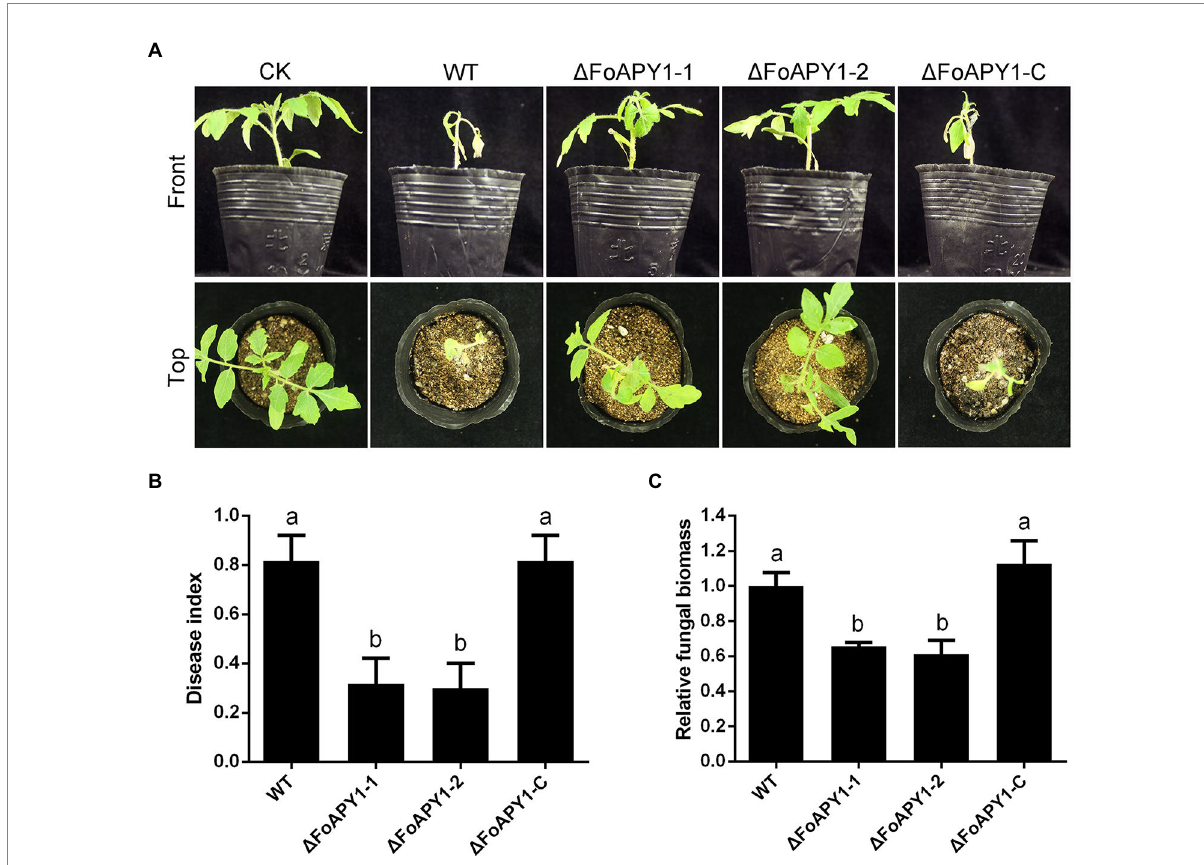
FIGURE 4 FoAPY1 is required for full virulence of F. oxysporum . (A) Pathogenicity assays on tomato seedlings inoculated with the conidial suspension of WT, two ∆ FoAPY1 mutant and ∆ FoAPY1-C complementation strains and imaged 20 days after inoculation. CK represents the plants treated with water as a blank control. The infection experiments were repeated three times. (B) Quantification of the disease indexes of the plants inoculated with all indicated strains. The disease index was calculated using the formula: disease index = Σ (number of plant leaves × grade value)/(total number of leaves × maximum grade value). (C) qRT–PCR analysis of fungal biomass in all plants infected by all F. oxysporum strains in this study. The relative fungal biomasses of the WT strain were set to values of 1. The constitutively expressed gene Sl18S was used as an internal reference. The experiment was performed for three replicates, and the average values were calculated. The different letters above the bars means mean significant differences at p <